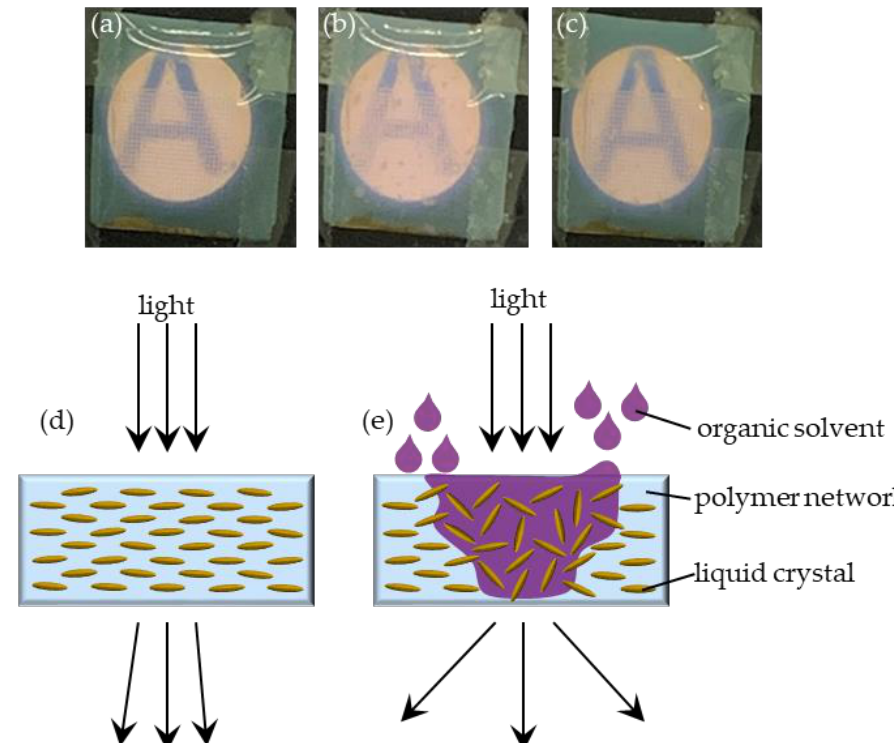
Figure 5. Images of patterned PDLC film ( a ) before exposure to acetone; ( b ) during exposure to acetone; ( c ) after complete volatilization of acetone; ( d , e ) mechanism of patterned PDLC film in organic solvent.